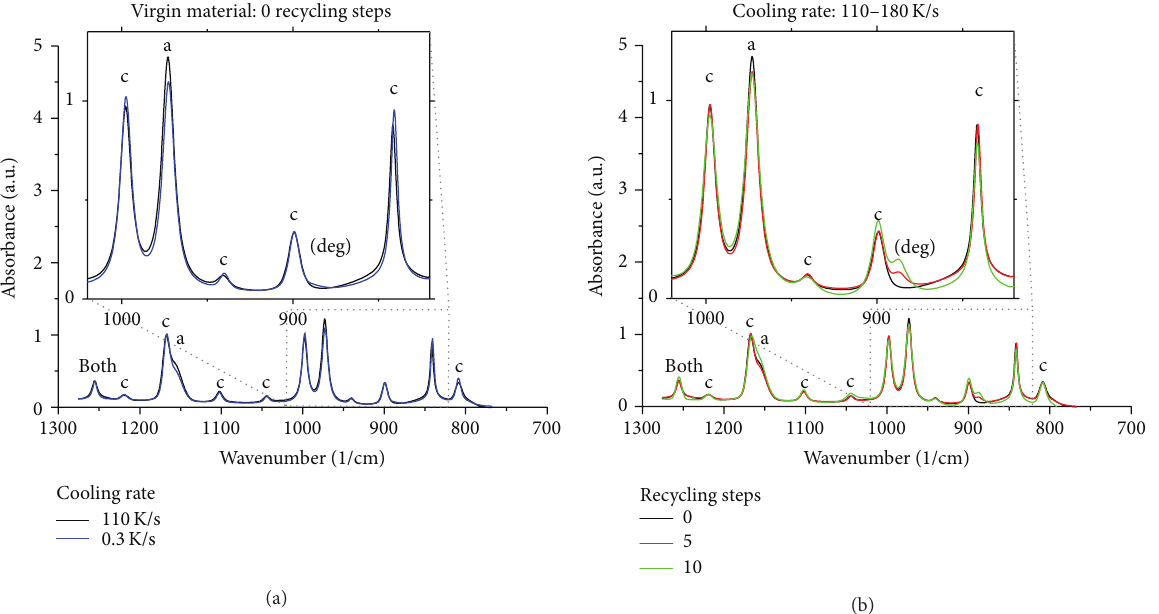
Figure 3: FTIR spectra collected on some of the samples analyzed in this work. In plot (a) spectra of virgin samples solidified at two cooling rates; in plot (b) spectra of samples undergone different recycling steps and solidified at the fastest applied cooling rate. The insets show a magnification of the plots.